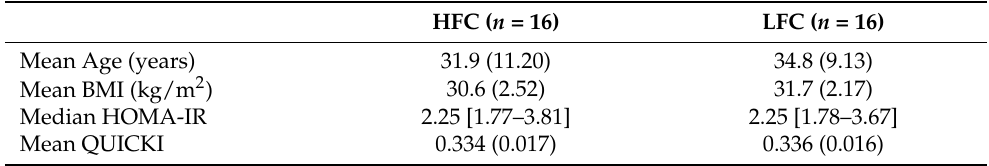
Table 1. Parameters at initial screening in those subsequently randomized to high-flavanol (HFC) or low-flavanol (LFC) cocoa drink. Data show the mean with SD in parentheses for normally distributed data, or the median with 25th–75th percentile in square brackets where distribution did not meet normality